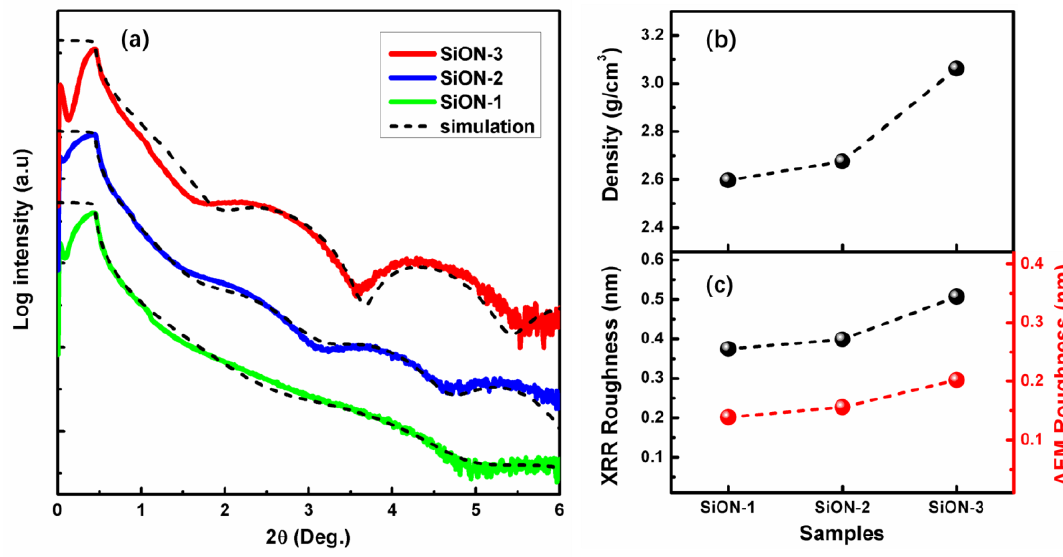
Figure 2. ( a ) Measured and simulated X-ray reflection (XRR) curves of three kinds of SiON film. ( b ) Density and ( c ) RMS roughness of these films obtained by XRR simulation.